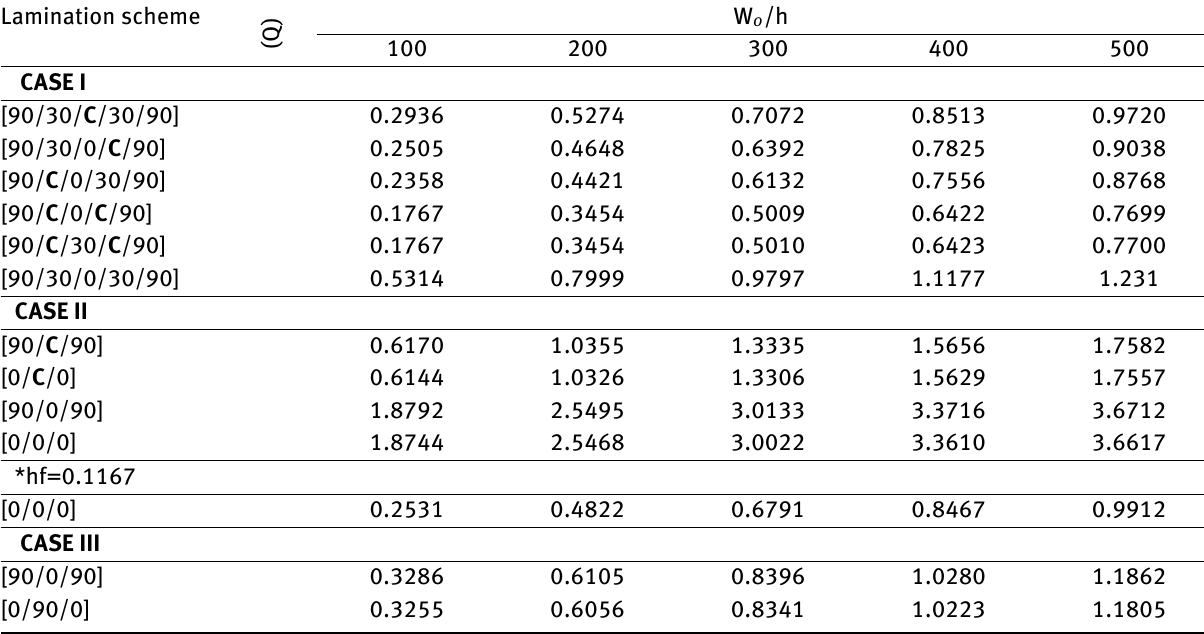
Table 3: Effect of variation in lamination scheme, load parameter and thickness of sandwich beam on transverse central deflection of SWCNTRC sandwich